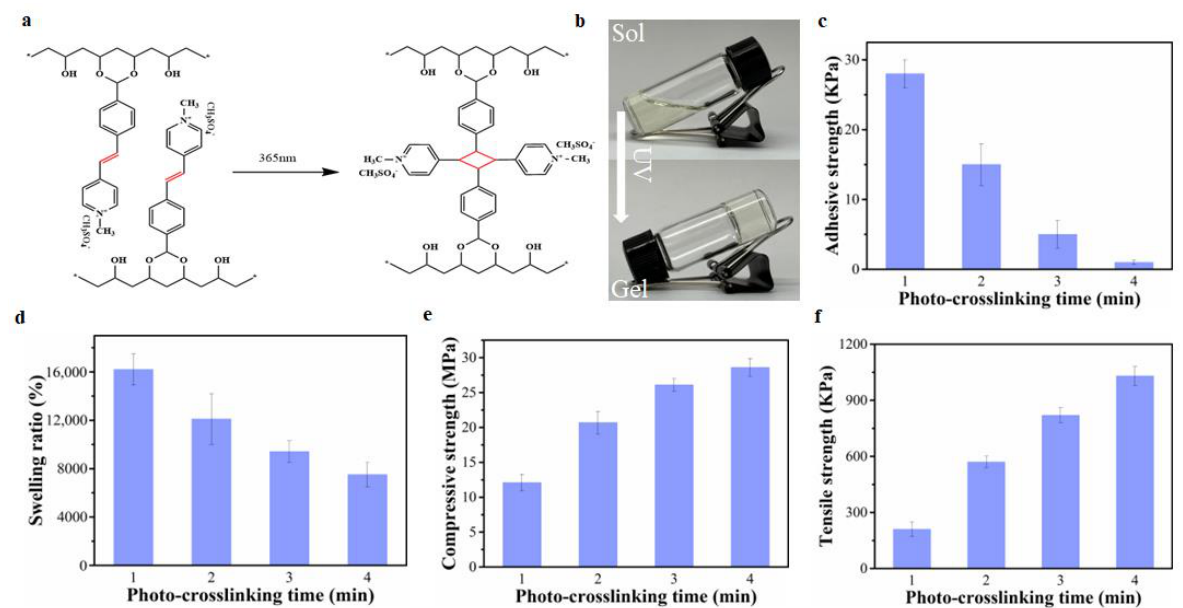
Figure 3. ( a ) The formation mechanism of PVA-SbQ hydrogels. ( b ) The preparation process of PVA-SbQ hydrogels. ( c ) The adhesive strength of PVA-SbQ hydrogels prepared by different photo-crosslinking times. ( d ) The swelling ratio of PVA-SbQ hydrogels prepared by different photo-crosslinking times. ( e ) The compressive strength of PVA-SbQ hydrogels prepared by different photo-crosslinking times. ( f ) The tensile strength of PVA-SbQ hydrogels prepared by different photo-crosslinking times.